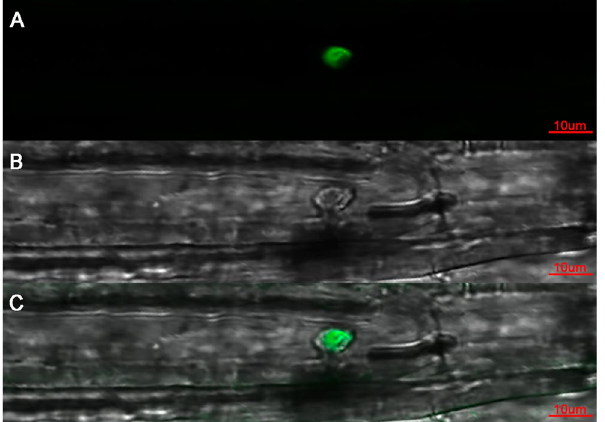
Figure 2. Subcellular localization of GhWRKY33 protein. Confocal images were taken of the hypocotyl cells of 35S:GhWRKY33-GFP transgenic Arabidopsis. ( A ) Confocal image of the hypocotyl cell under the GFP channel. ( B ) The transmitted light image of the same cell in image A. ( C ) The merged images of confocal image and the bright-field image. Bar = 10 μ m.